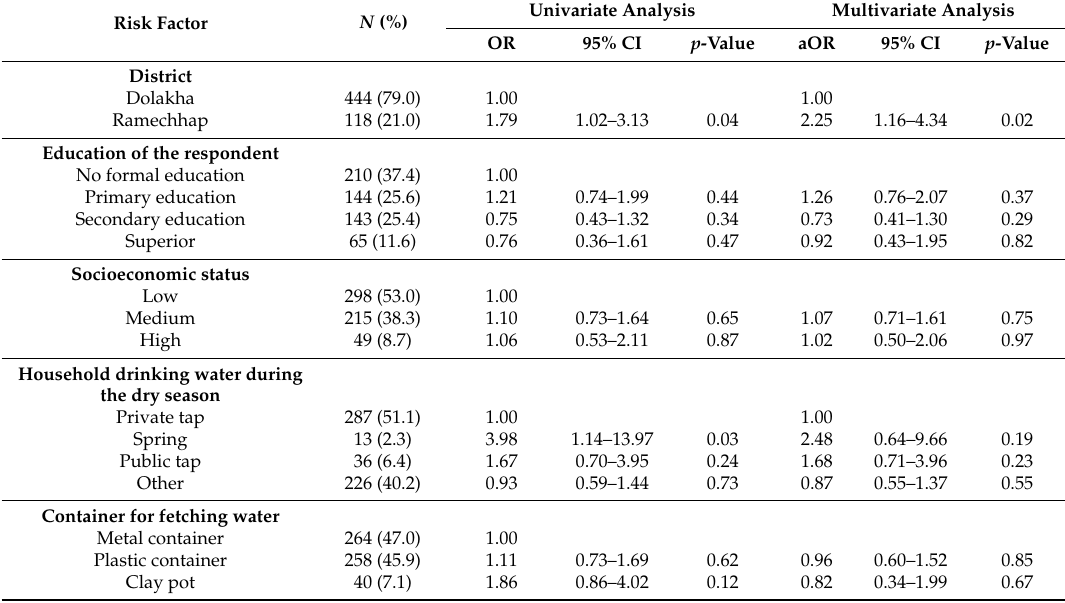
Table 6. Results from univariate and multivariate logistic regression analysis for thermo-tolerant coliforms (TTC) from water samples from households of Dolakha and Ramechhap districts, Nepal (sampling period: March–May